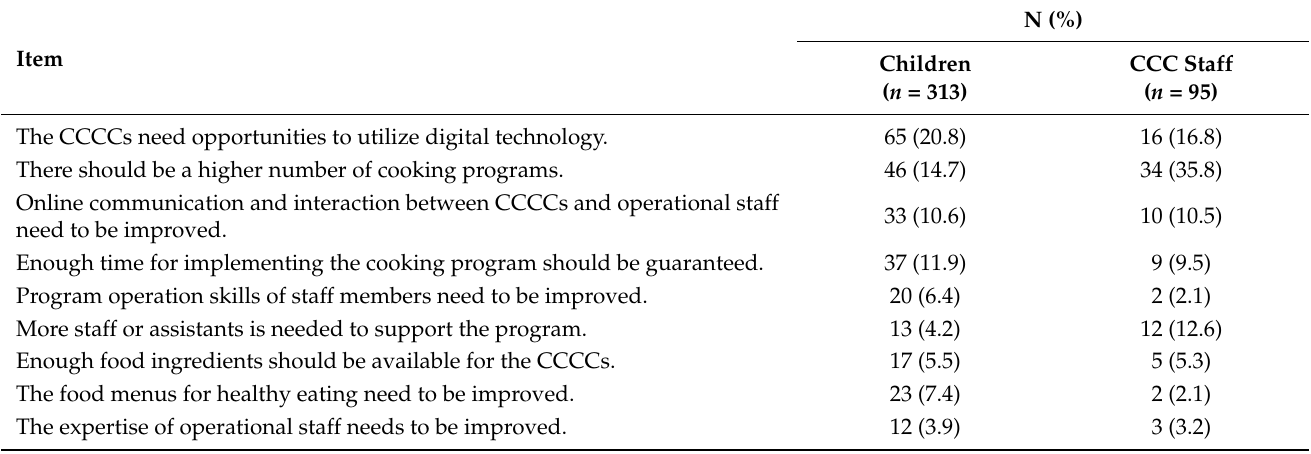
Table 3. Participants’ suggestions for improving the